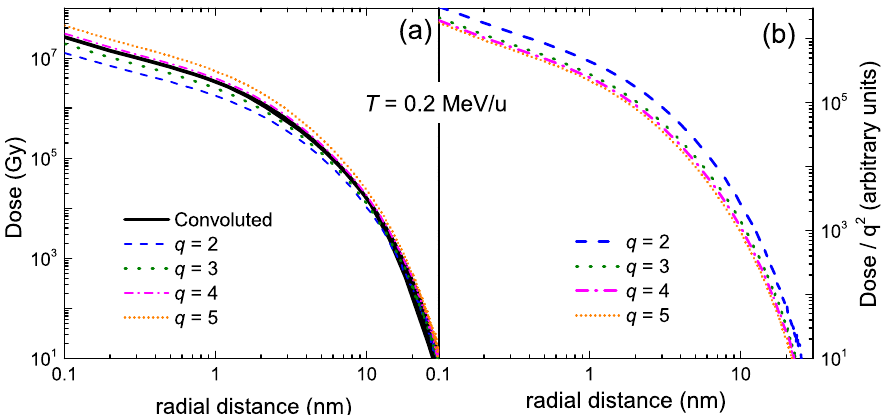
Figure 10. ( a ) Dose deposited by 0.2 MeV/u carbon ions in liquid water, as a function of the radial distance from the ion path, for different charge states q of the ion, obtained with the LR-TDDFT model of the ELF. ( b ) The same quantity, divided by the square of the ion charge, in arbitrary units.